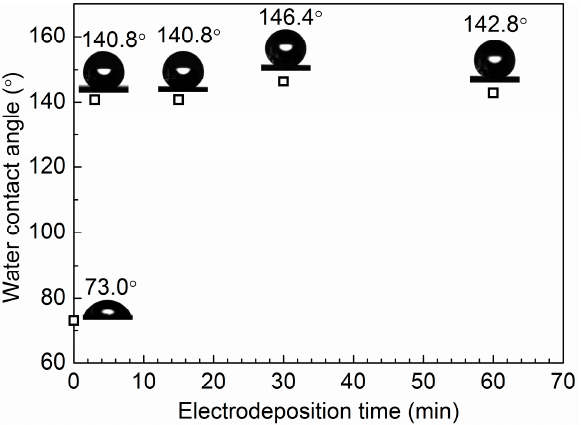
Figure 5. The water contact angle variations of coatings prepared at 80 V with different deposition times.